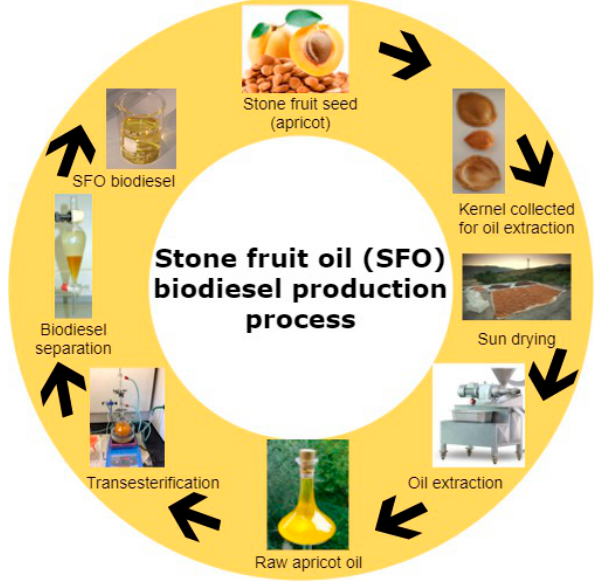
Figure 1. SFO biodiesel production process. Table 1. Physicochemical properties, ASTM standards and measuring tools.